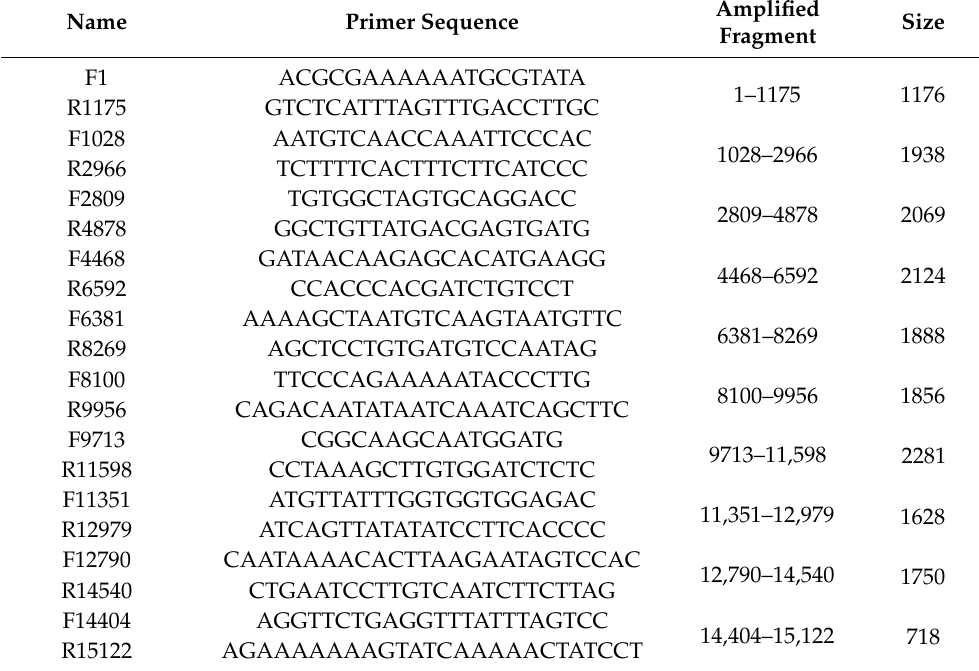
Table 2. Primers used for RT-PCR amplification of the BRSV